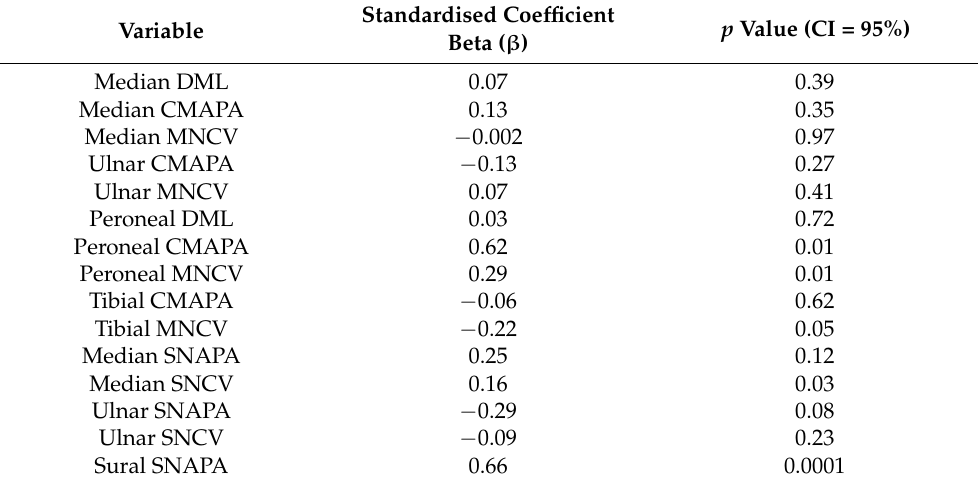
Table 7. Multivariate analysis between HRV DB (dependent variable) and independent